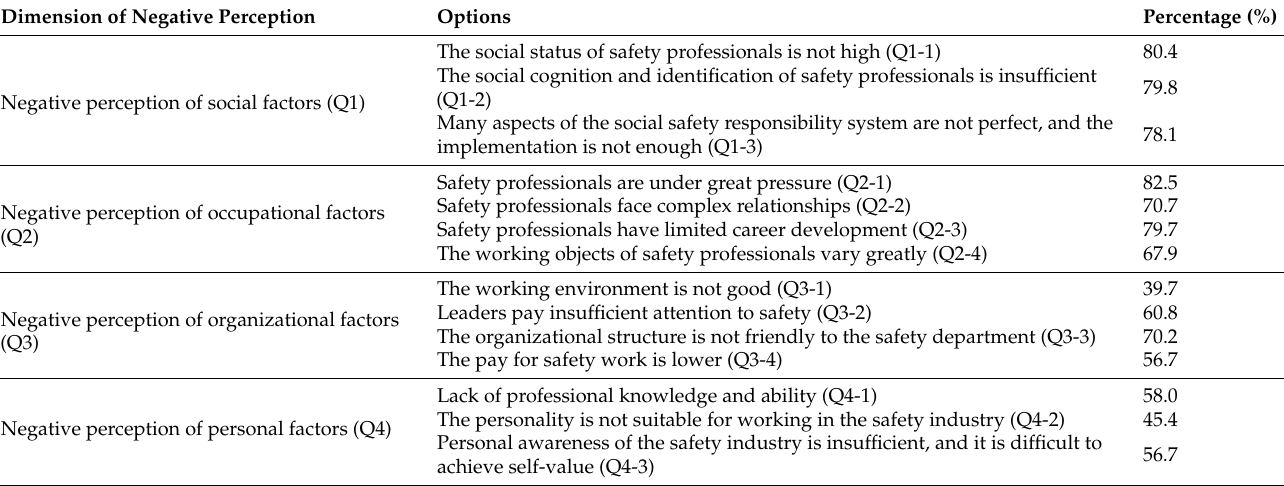
Table 4. Selection and scores of negative perception questions (N = 526).